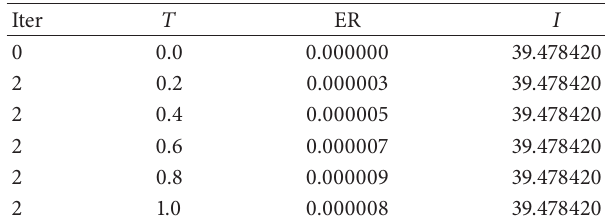
Table 5: Periodic solution 𝑘 1 = 𝑘 2 = 𝛼 = 1